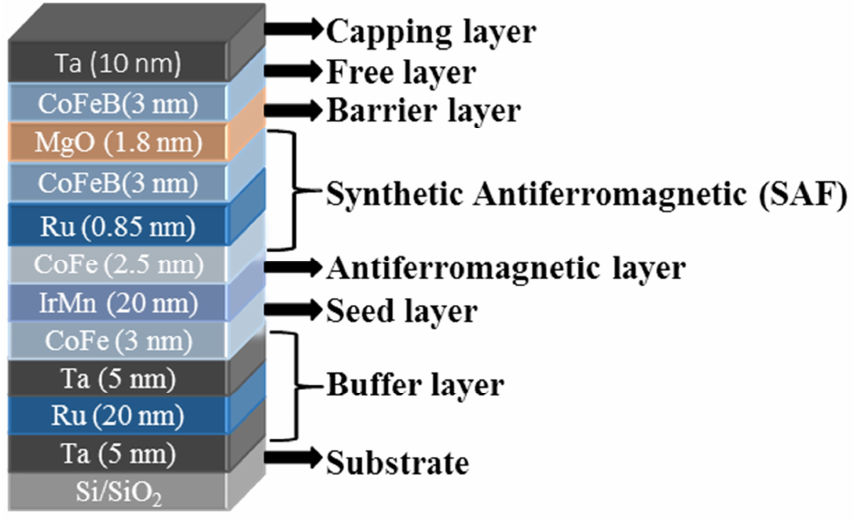
Figure 1. Schematic representation of the TMR multilayer structure.